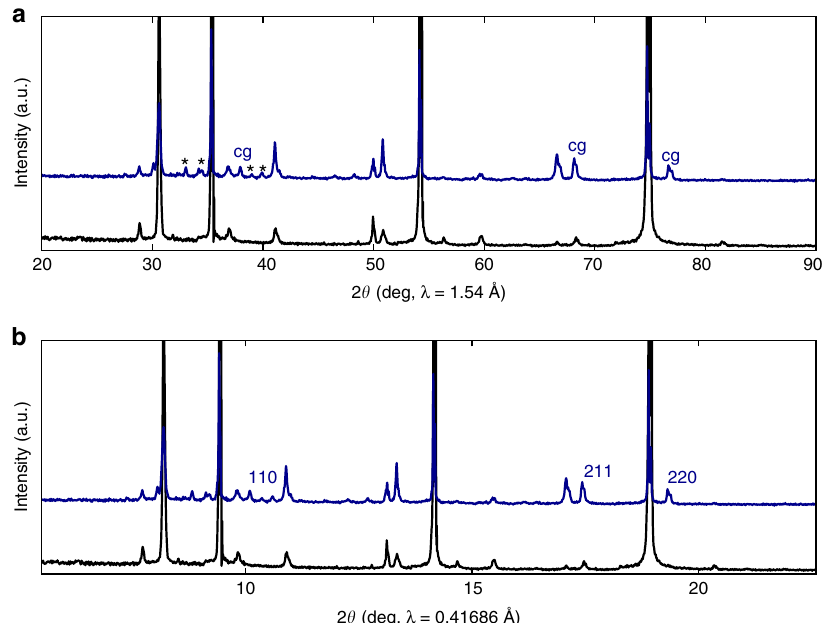
Fig. 3 X-ray powder diffraction patterns. a Diffraction patterns measured using CuK α radiation for NaN 3 powder before (diffraction pattern at the bottom) plasma reaction and after (diffraction pattern on top) plasma reaction. The lines indicated by < cg > at 37, 66 and 77 2 θ degrees correspond closely to the (110), (211) and (220) re fl ections of the cubic gauche structure of polymeric nitrogen reported by Eremets and co-workers 4, 5 . The strong lines correspond to unreacted, pristine NaN 3 , and the lines indicated by asterisks can be from phase I discussed in the text or a sodium nitride phase. b The X-ray diffraction pattern converted to the X-ray beam wavelength of 0.41686Å used by Eremets and coworkers 4, 5 . The (110), (211) and (220) re fl ections of the cubic gauche structure emerge clearly in the plasma-reacted sample (top) and are completely absent in the pristine NaN 3 sample